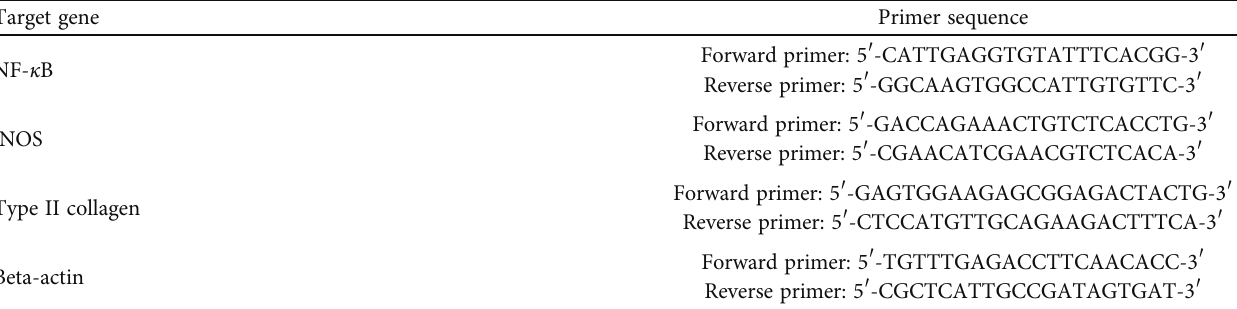
Table 1: Primer sequences for NF- κ B, iNOS, and type II collagen mRNA.